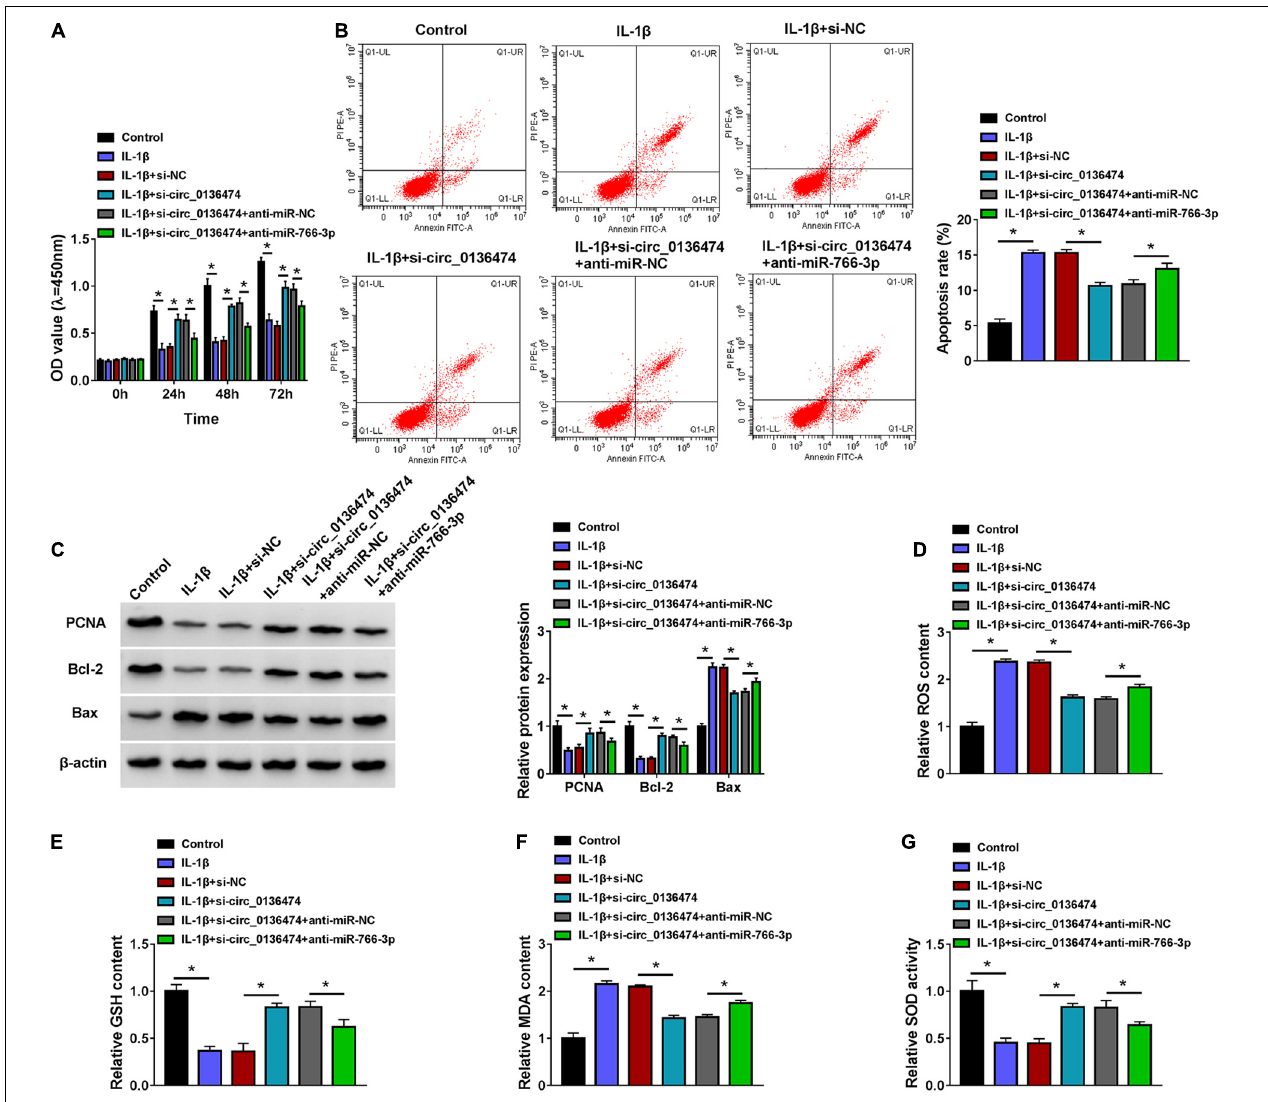
FIGURE 5 | Blocking miR-766-3p could block the role of circ_0136474 knockdown in IL-1 β -induced chondrocytes. CHON-001 cells were transfected with si-circ_0136474/NC or si-circ_0136474 combined with anti-miR-766-3p/NC prior to treatment of IL-1 β (10 ng/ml) for 24 h. (A) CCK-8 monitored the OD values of inoculated cells during 72 h. (B) FCM tested the apoptosis rate (%). (C) Western blotting examined the relative protein expression of PCNA, Bcl-2, and Bax. (D–G) Special assay kits determined the levels of ROS, GSH, MDA, and SOD. * P < 0.05 was determined by ordinary one-way ANOVA or two-way